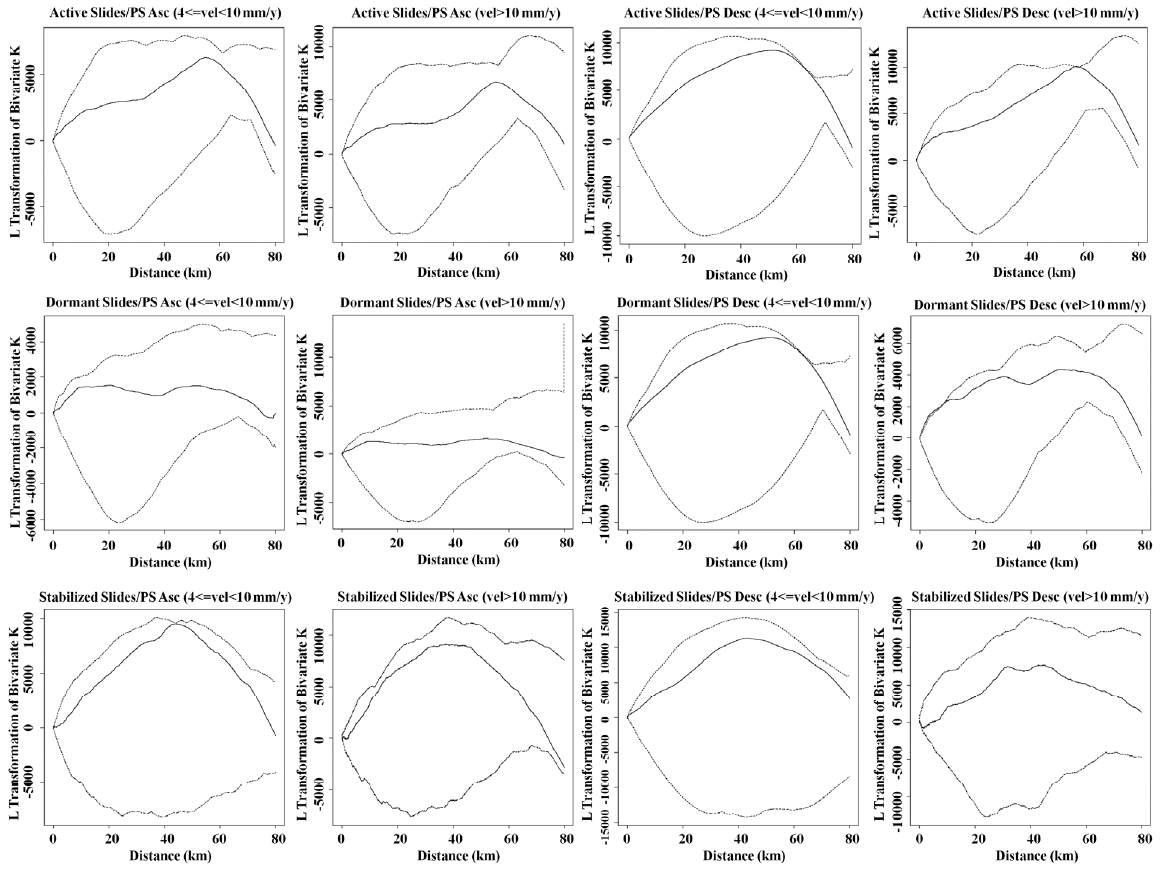
Figure 3. The results of the bivariate K-function analysis for assessing spatial relationships between PSI point targets and occurrences of slides across the Arno River basin. Dashed lines indicate 98% confidence intervals and solid lines represent the observed values. Observations outside the confidence intervals reveal spatial dependence of clustering ( above ) or repelling ( below ) at corresponding distances. Observations inside the confidence intervals indicate spatial